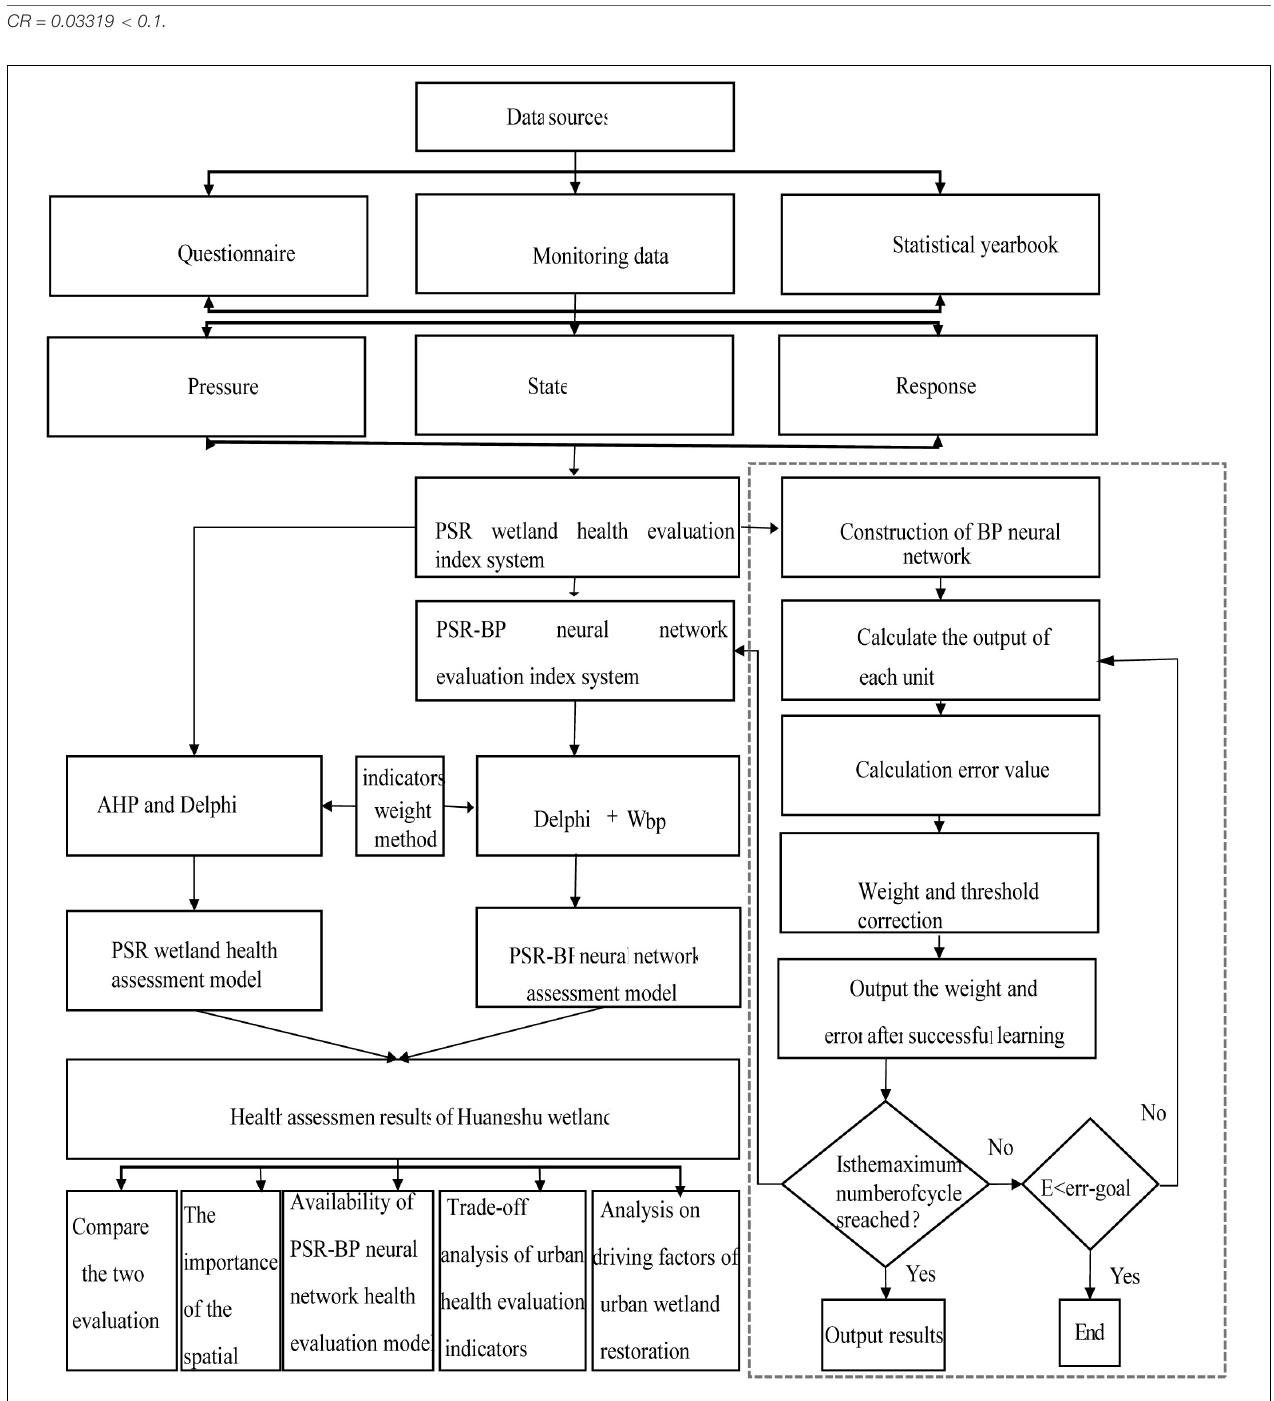
FIGURE 2 | PSR-BP neural-network-based wetland health assessment model.